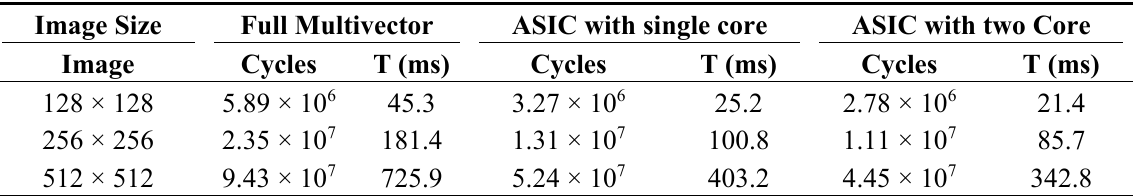
Table 6. Five geometric additions for rotor